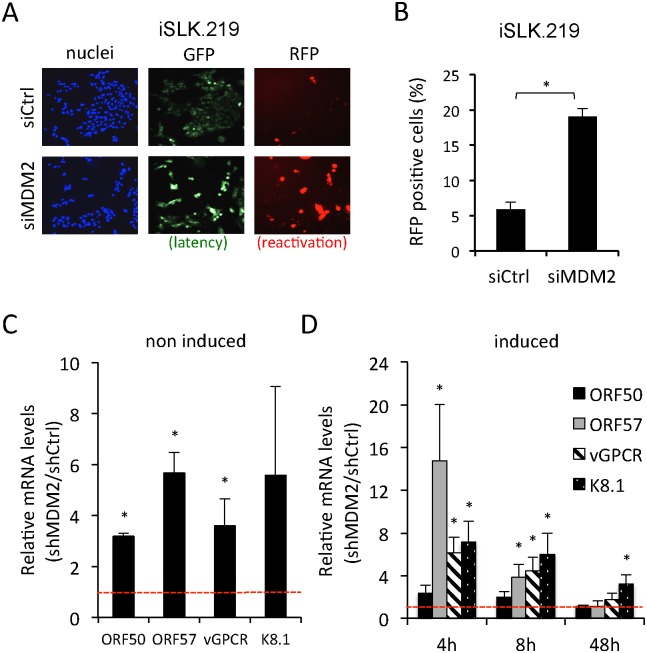
siRNA screen identifies MDM2 as a novel regulator of KSHV reactivation.(A) Fluorescence images of iSLK.219 cells treated with indicated siRNAs. Virus reactivation was induced 48h after siRNA transfection by a low-dose (0.05 μg/ml) doxycycline treatment and the extent of reactivation measured by detection of RFP positive cells using high-content fluorescence imaging and automated image analysis. Cells were visualized with Hoechst 33342 (Nuclei, blue), GFP (marker of latency, green) and RFP (marker of reactivation, red). (B) Quantification of the experiment shown in (A). The results are the average of three independent experiments. The error bars represent the standard error of the mean (SEM). * p<0.05. (C) qRT-PCR analysis of ORF50, ORF57, vGPCR and K8.1 transcripts from latent, DMSO-treated BC-3 cells transduced for 72 h with lentiviruses expressing nonspecific control (shCtrl) or MDM2 targeting shRNAs (shMDM2). The relative mRNA levels obtained from the shMDM2 treated cells were normalized to the corresponding values from shCtrl treated cells. (D) qRT-PCR analysis of ORF50, ORF57, vGPCR and K8.1 transcripts from BC-3 treated with shRNA as in (C) and reactivated with TPA for indicated times. Values normalized as in (C). The error bars in (C) and (D) represent the SEM of three independent experiments. * p<0.05